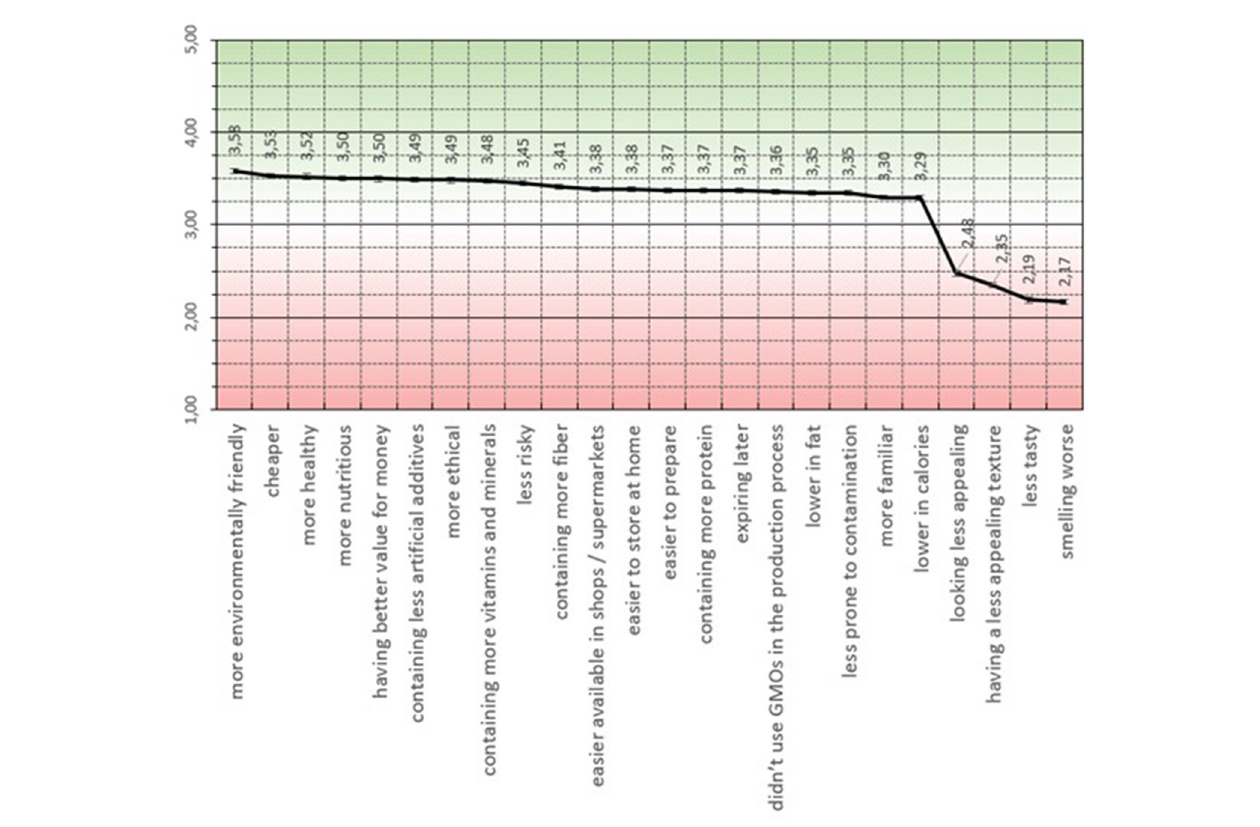
FIGURE 3 | Mean ratings of how much the attitude toward synthetic protein would become more positive or negative if synthetic protein was more of the aspect (e.g., more environmentally friendly) than farmed protein. The error bars represent 95% credibility intervals estimated with Bayesian estimation ( N =